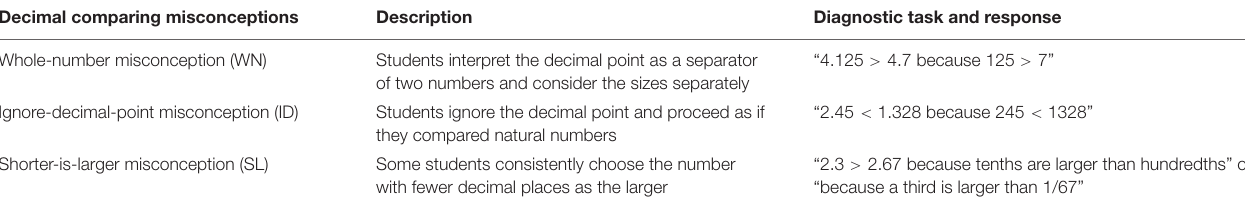
TABLE 2 | Common misconceptions when comparing decimal fractions (cf. Moloney and Stacey, 1997). Decimal comparing